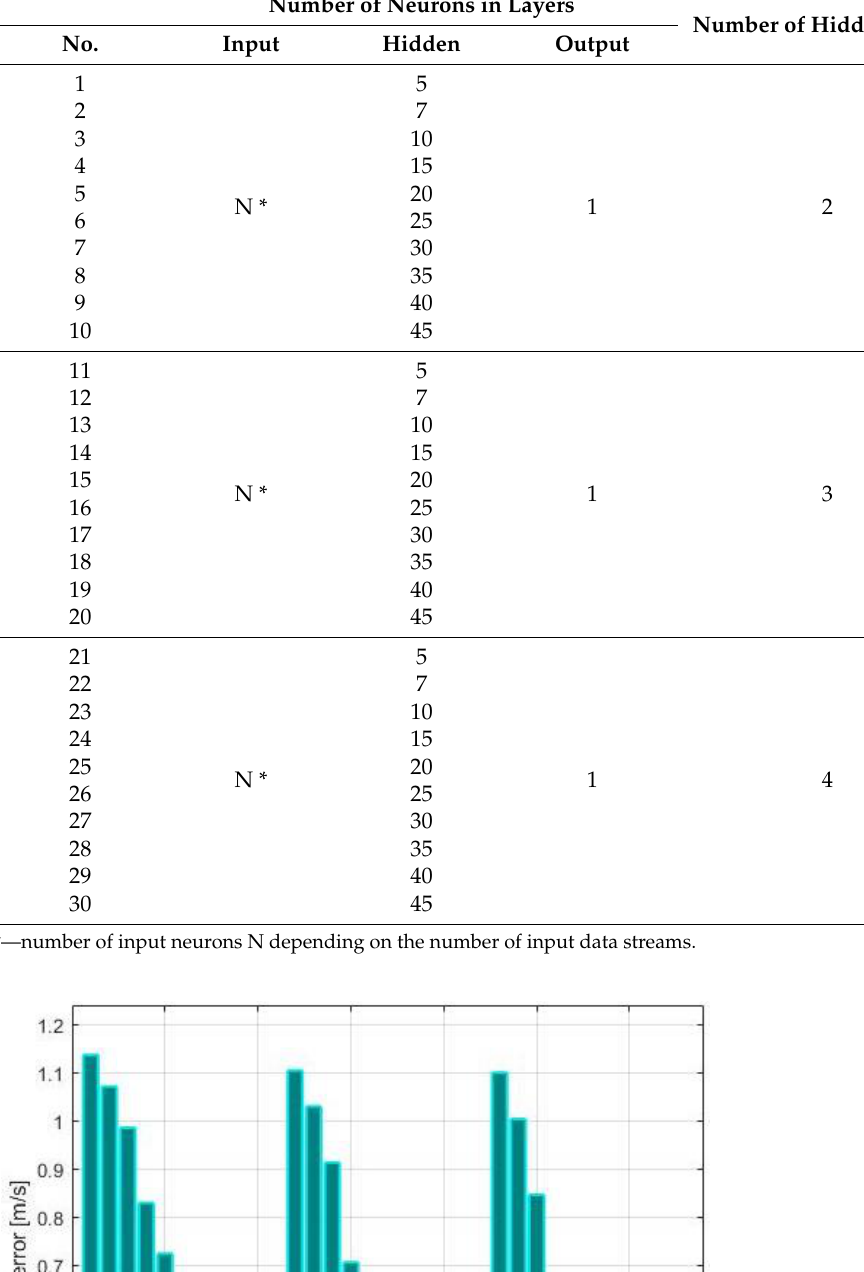
Number of Neurons in Layers